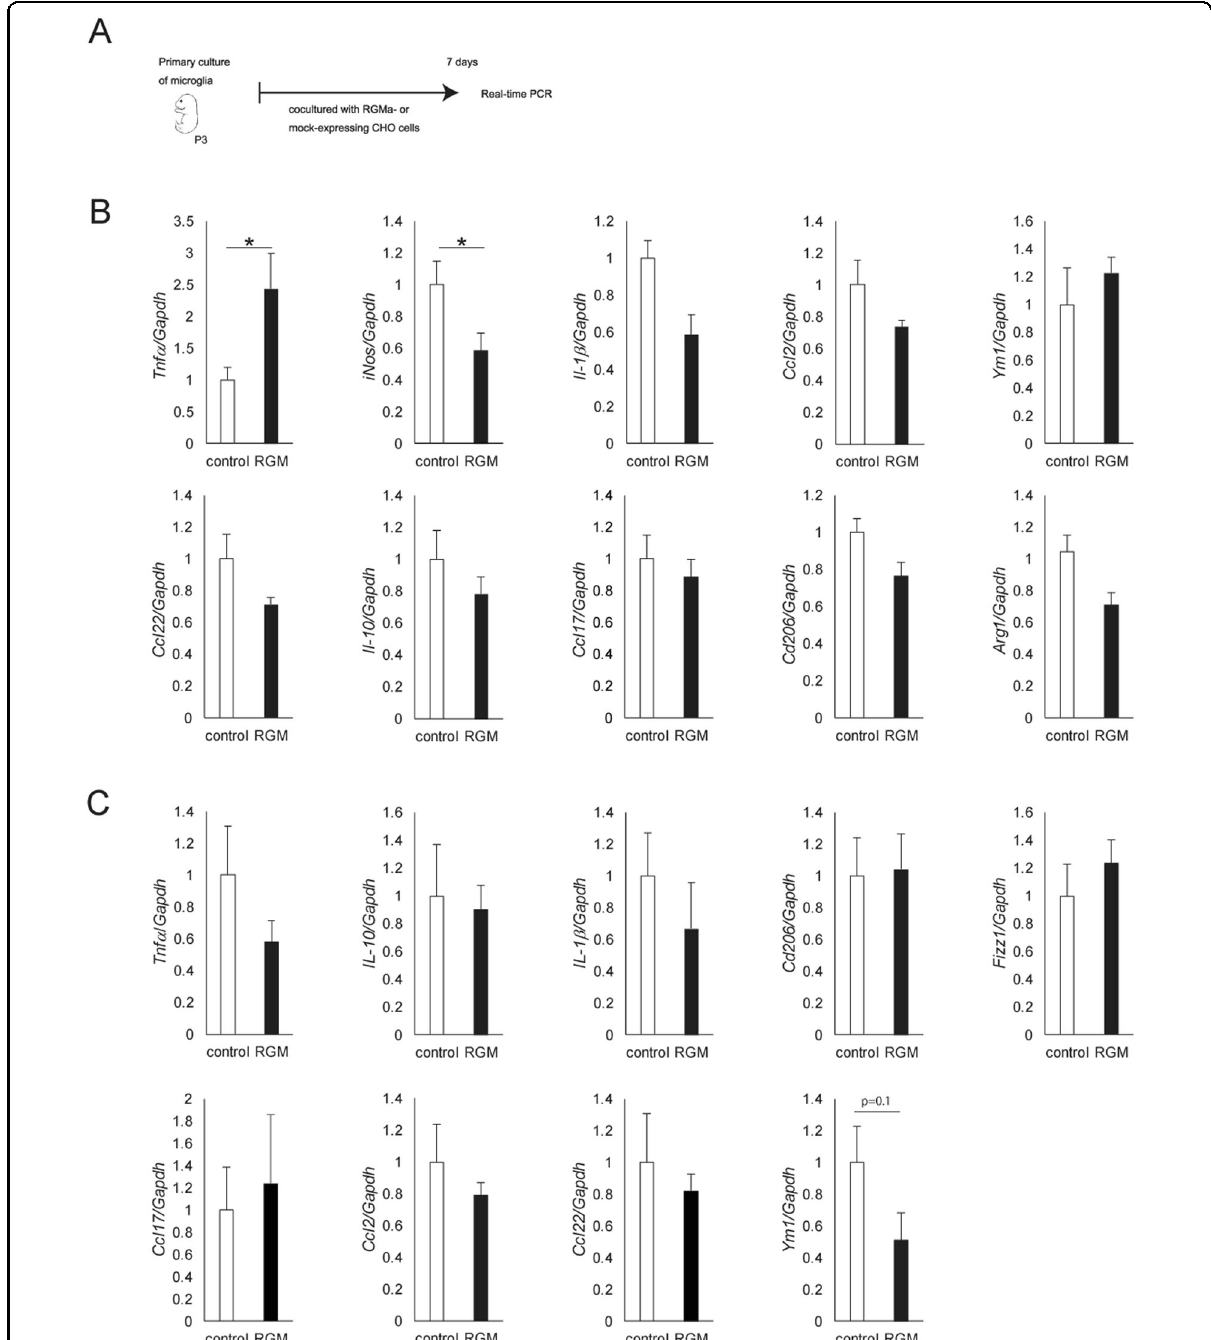
Fig. 8 RGMa increases mRNA expression of Tnf α in microglia. A Schematic representation of the timeline of primary culture, and treatment with RGMa. B , C Relative mRNA expression of pro-in fl ammatory cytokines, chemokines, and M1 or M2 markers in cultured microglia ( B ) and in microglia isolated from brains of Cx3cr1CreERT2; Ai14 mice ( C ). The mRNA level of Tnf α is increased in the microglia cocultured with RGMa compared with control. n = 4 – 5 ( B ), n = 3 – 4 ( C ). * P < 0.05, Student ’ s t